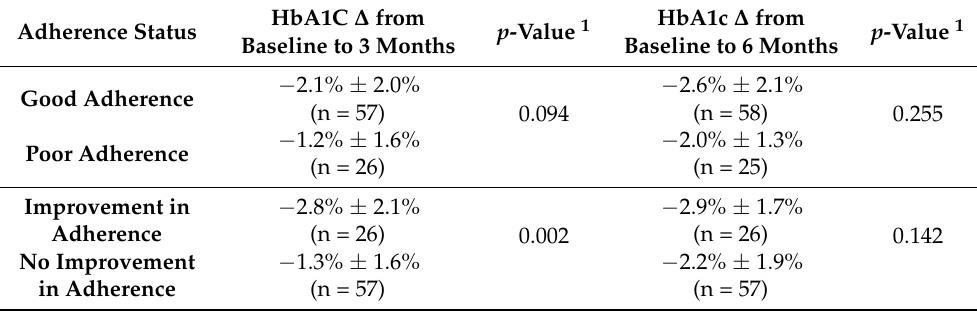
Table 3. Mean HbA1c change over time by adherence status, mean ± SD (n = 83).